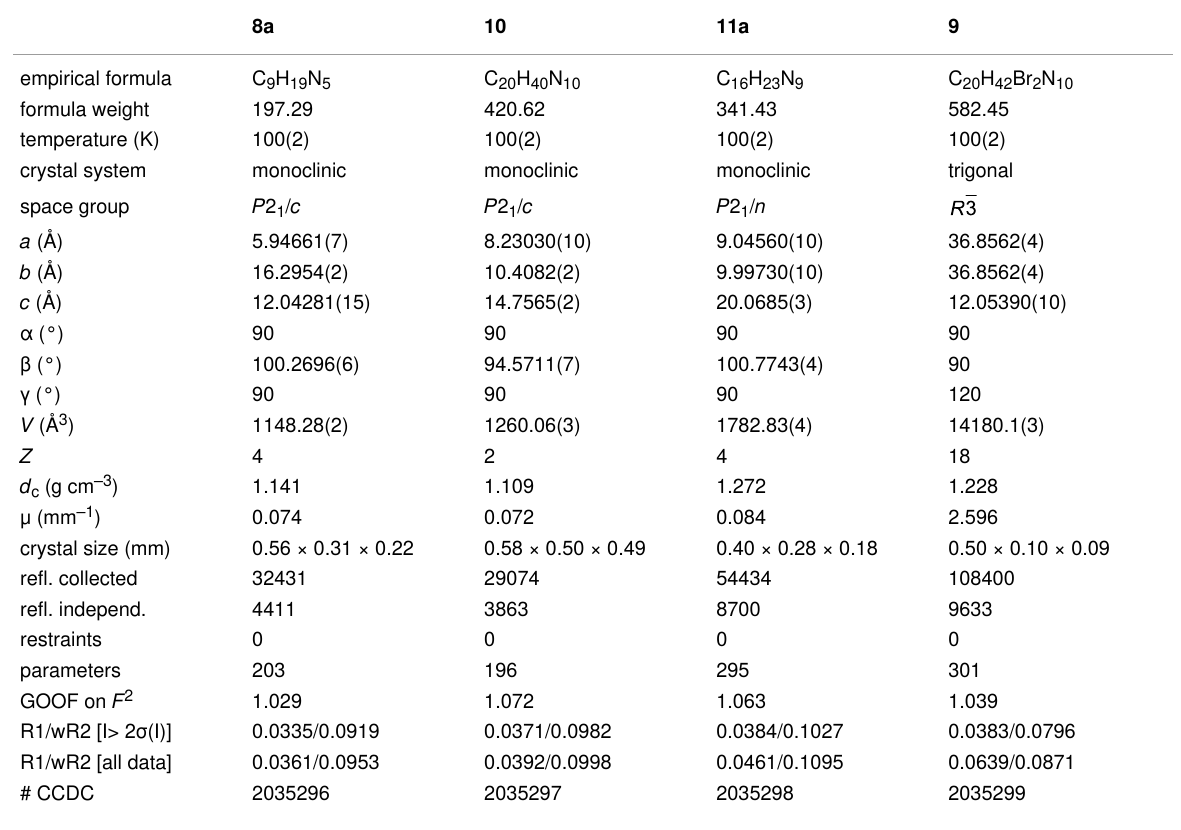
Table 1: Single crystal X-ray data and structure refinement details for compounds 8a , 10, 11a , and 9